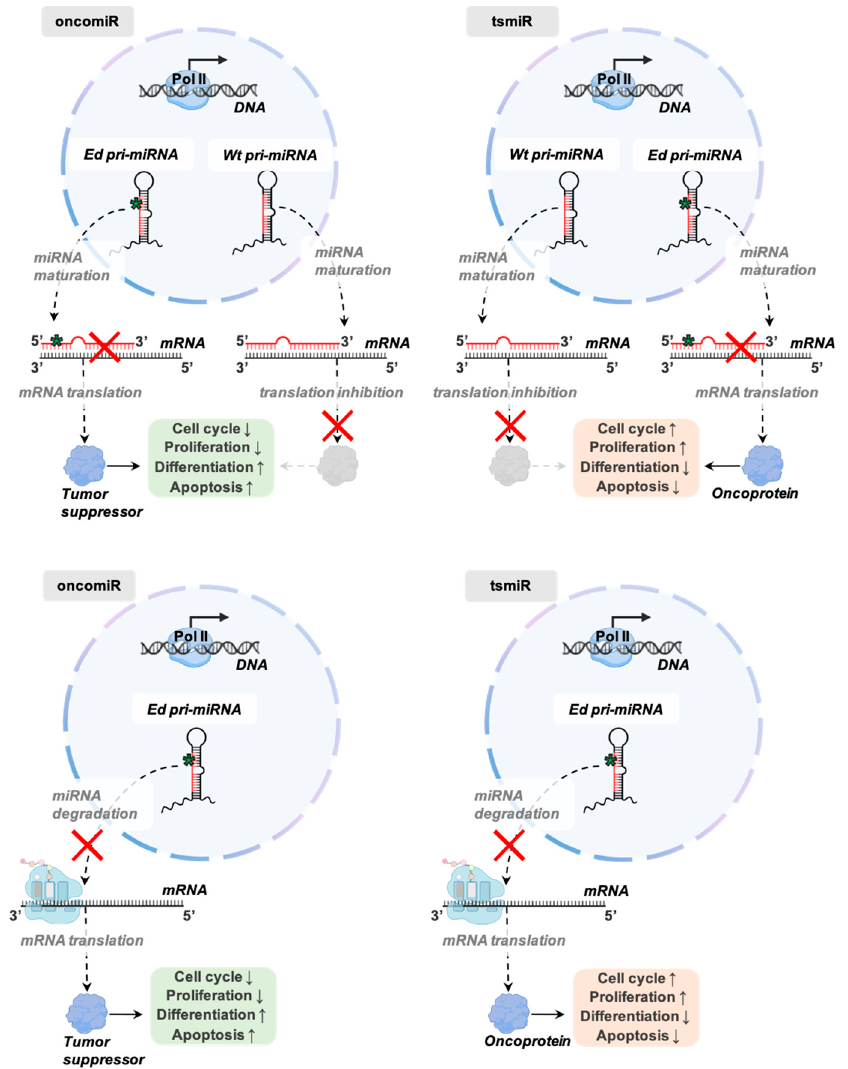
Figure 4. Possible effects of miRNA editing in the context of cancer. Editing of mature miRNAs can prevent the targeting of complementary regions in the 3 ′ UTRs of original mRNAs. In case an editing event disrupts the base pairing of an oncomiR with its target mRNA (transcribed from a tumor suppressor gene), the translational process will lead to the expression of the tumor suppressor protein, increasing processes related to cell cycle arrest, differentiation, and/or apoptosis (top, left). In case an editing event disrupts the base pairing of a tsmiR with its target mRNA (transcribed from a proto-oncogene), the translational process will lead to the expression of the oncoprotein, increasing processes related to cell cycle progression, proliferation, and migration (top, right). However, editing of pri- or pre-miRNAs can cause the blockage of their biogenesis, significantly decreasing the expression of their related mature miRNAs. Thus, similar considerations can be done in the case of the underexpressed miRNA functions as an oncomiR (bottom, left) or a tsmiR (bottom, right). In some circumstances, target redirecting could relate to the targeting of distinct regions of the same 3’UTR in an mRNA. This is the case of unedited miR-27a-3p and its edited version at position 5 [104]. By employing a luciferase assay, it was demonstrated that both these versions of miR-27a-3p were capable of targeting the MET transcript, apparently with the same efficacy, albeit at two distinct miRNA-targeting sites. However, edited miR- 27a-3p also displayed a functional shift, as it lost the ability to target the EGFR transcript and contributed to phenotype alteration in MCF-7 cells